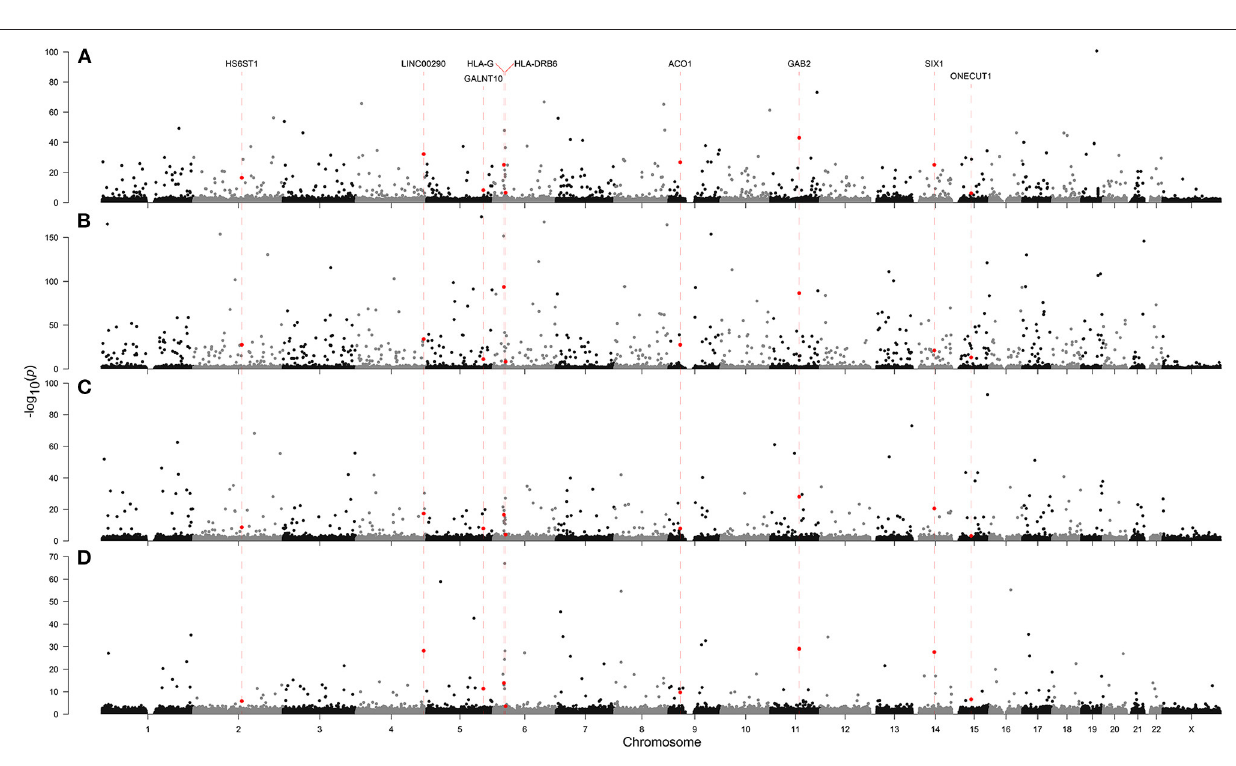
FIGURE 3 | Genome-wide association with (A) Alzheimer’s disease, (B) Parkinson’s disease, (C) motor neuron disease, and (D) myasthenia gravis in the Affymetrix Axiom Biobank Array. Dashed red lines and red points indicate SNPs which appeared in the top 1,000 associations by asymptotic Cochran-Armitage trend test p -value in all four neurological